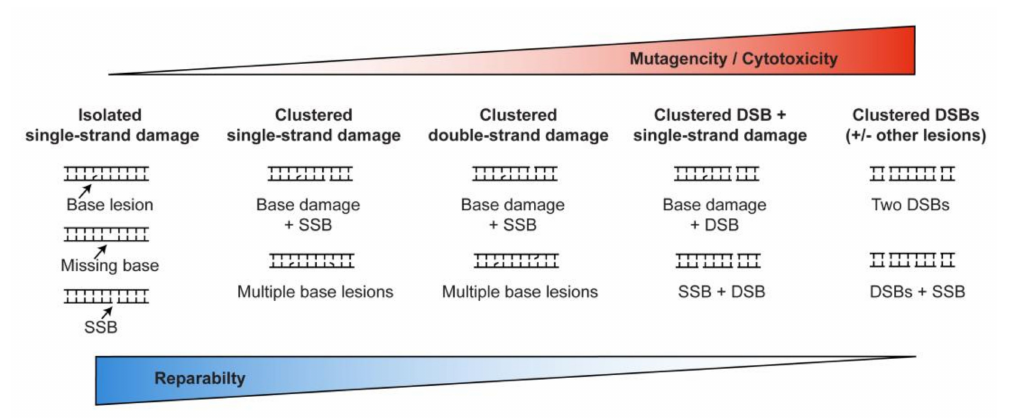
Figure 1. Relationships among DNA damage complexity, reparability, mutagenesis, and cytotoxicity. The triangles above and below indicate lesser to greater biological e ff ects that are inversely proportional to the reparability of isolated vs. clustered DNA